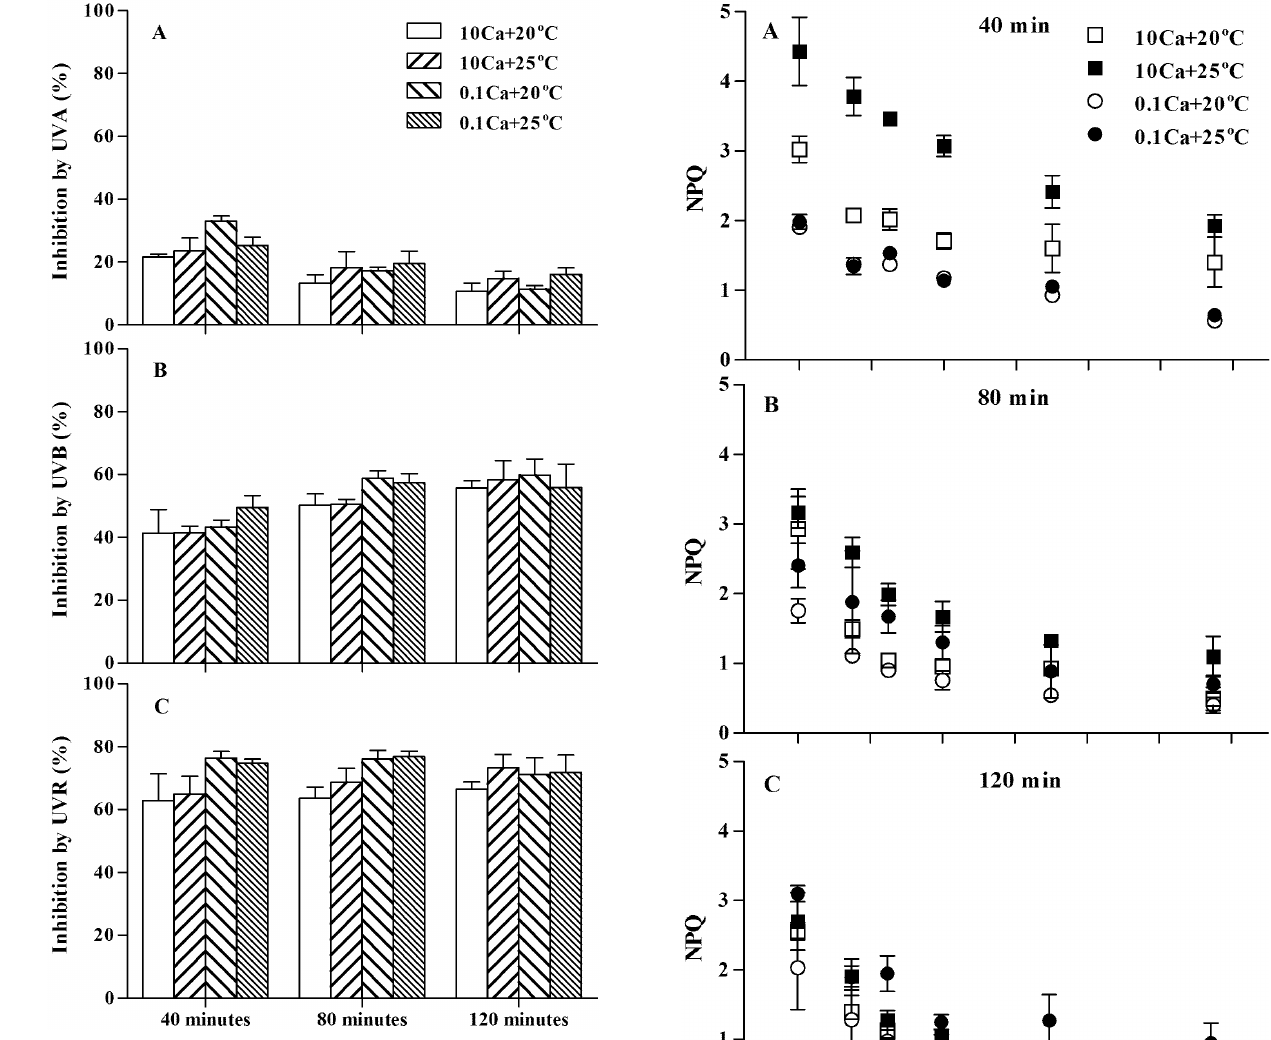
Fig. 3. Inhibition of the effective photochemical quantum yield of Emiliania huxleyi cells due to: (A) UVA, (B) UVB and, (C) UVR after 40, 80 and 120min of exposure to artificial radiation. The lines on top of the bars represent the standard deviations ( n = 3).